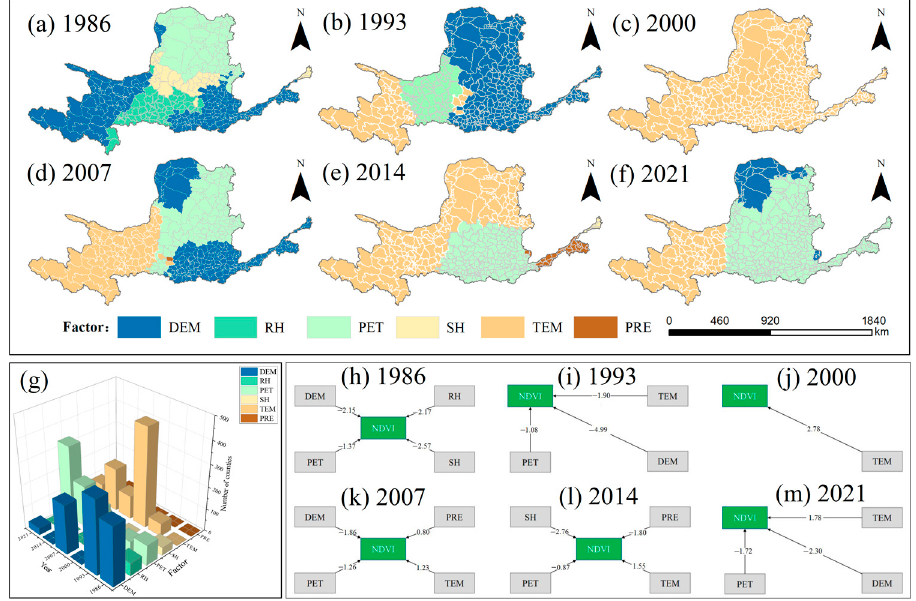
Figure 7. Spatial distribution ( a – f ), area ratio ( g ), driving force value ( h – m ) of the strongest control- ling factors at the county scale in the YRB from 1986 to 2021. factors at the county scale in the YRB from 1986 to